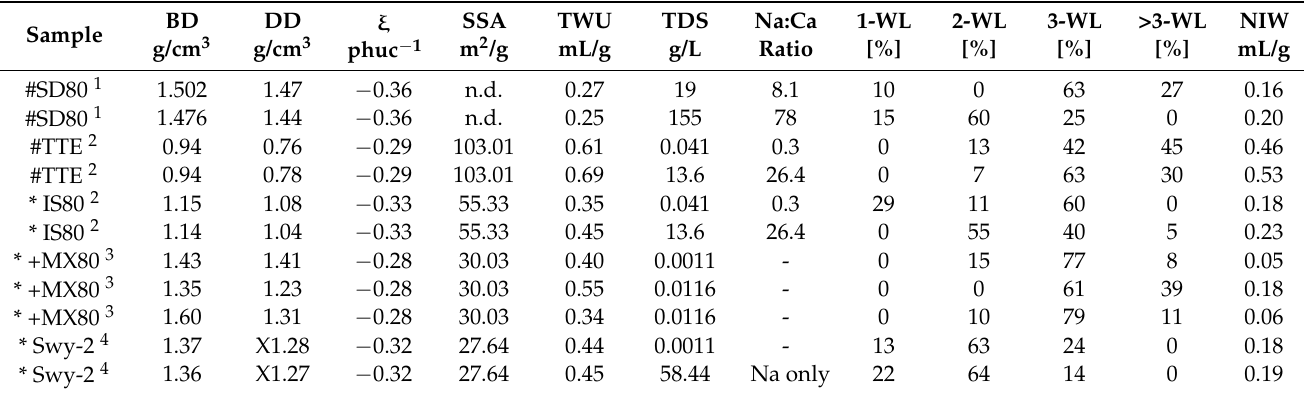
Table 3. List of samples with corresponding parameters from this study 1 ; Warr and Berger 2 , 2007; Perdrial and Warr 3 , 2011; Berger, 2008 4 [9,22,30]. BD = bulk density, DD = dry density, ξ = total layer charge, SSA = specific surface area, TWU = total water uptake, TDS = total dissolved solids, NIW = non-interlayer water. * = Na-smectite, # = Ca-smectite, + = estimation for Millipore water. n.d. = not